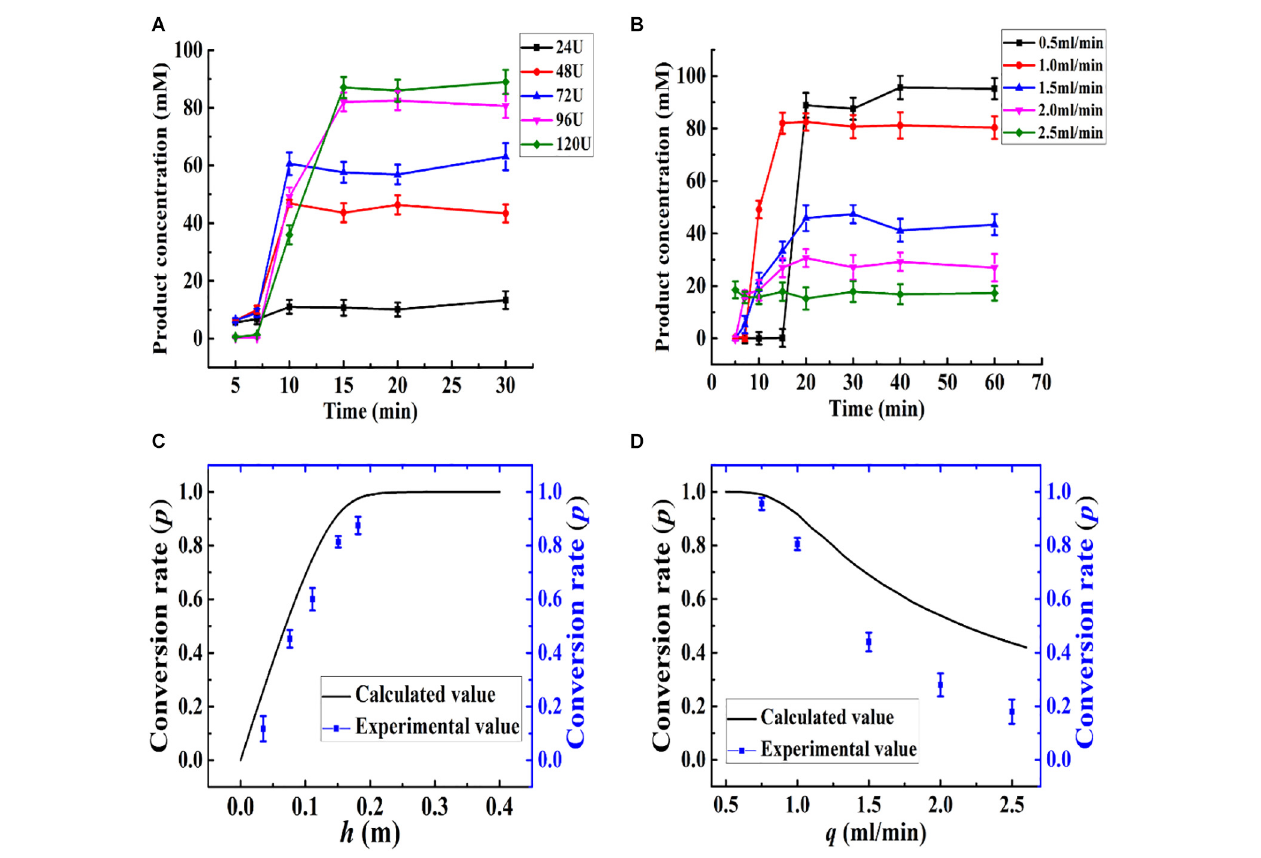
FIGURE 8 | (A) Effect of the amount of Aga-ASNase addition on catalytic efficiency of enzyme reactor. The effluent through the reactor from 0 to 30 min was collected and detected. The Aga-ASNase addition of 24, 48, 72, 96, and 120 U was equal to the column height of 0.038, 0.075, 0.112, 0.15, and 0.185 m, respectively. (B) Effect of the volume flow rate on catalytic efficiency of an enzyme reactor. The effluent through the reactor from 0 to 60 min was collected and detected. (C) Calculated and experimental values of the effects of column height on conversion rate. (D) Calculated and experimental values of the effects of volume flow rate on conversion rate.